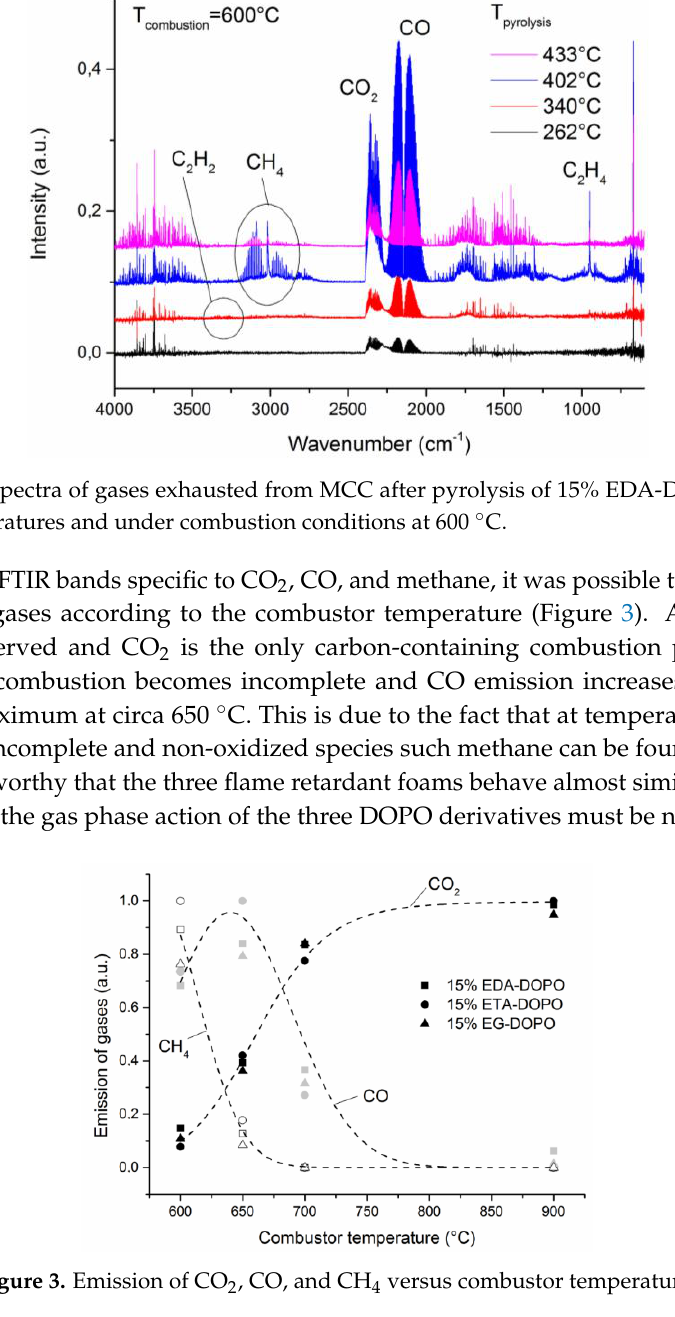
Figure 3. Emission of CO 2 , CO, and CH 4 versus combustor temperature.